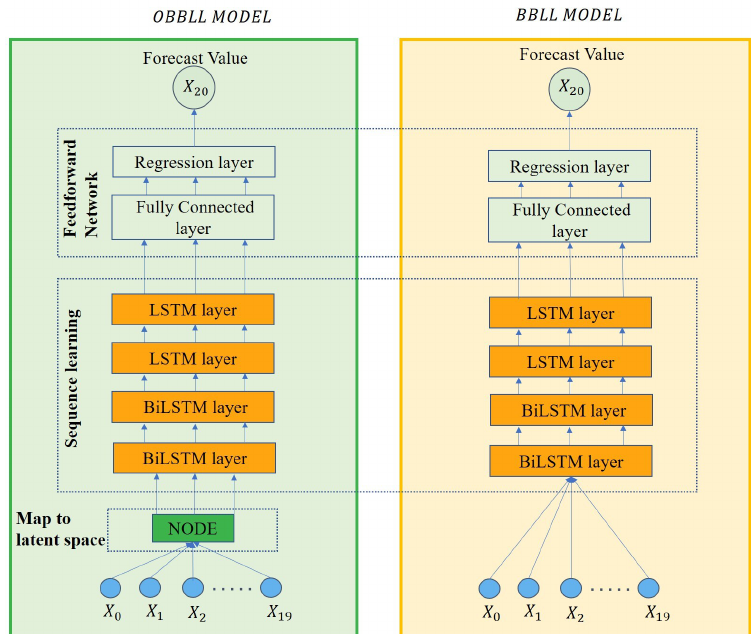
Figure 8. The model structures of OBBLL and